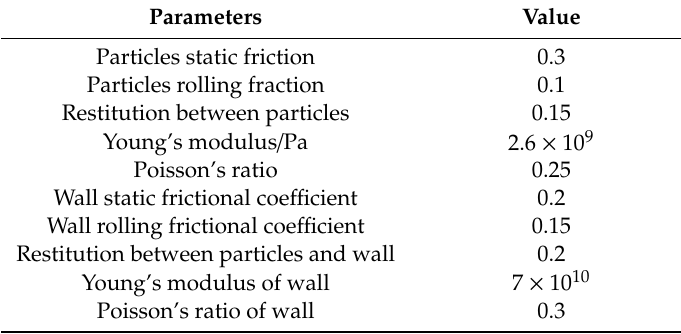
Table 2. Parameters used in DEM